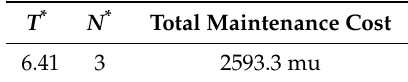
Table 8. Case 2: Maintenance plan for individual maintenance